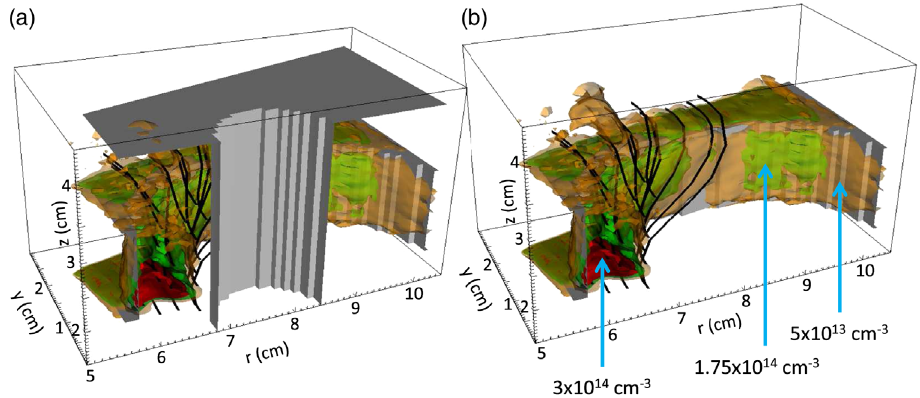
FIG. 4. (a) Plasma iso-density contours and magnetic field streamlines at t ¼ 60 ns from run 5r. In (b), the anode components of the convolute are removed from the